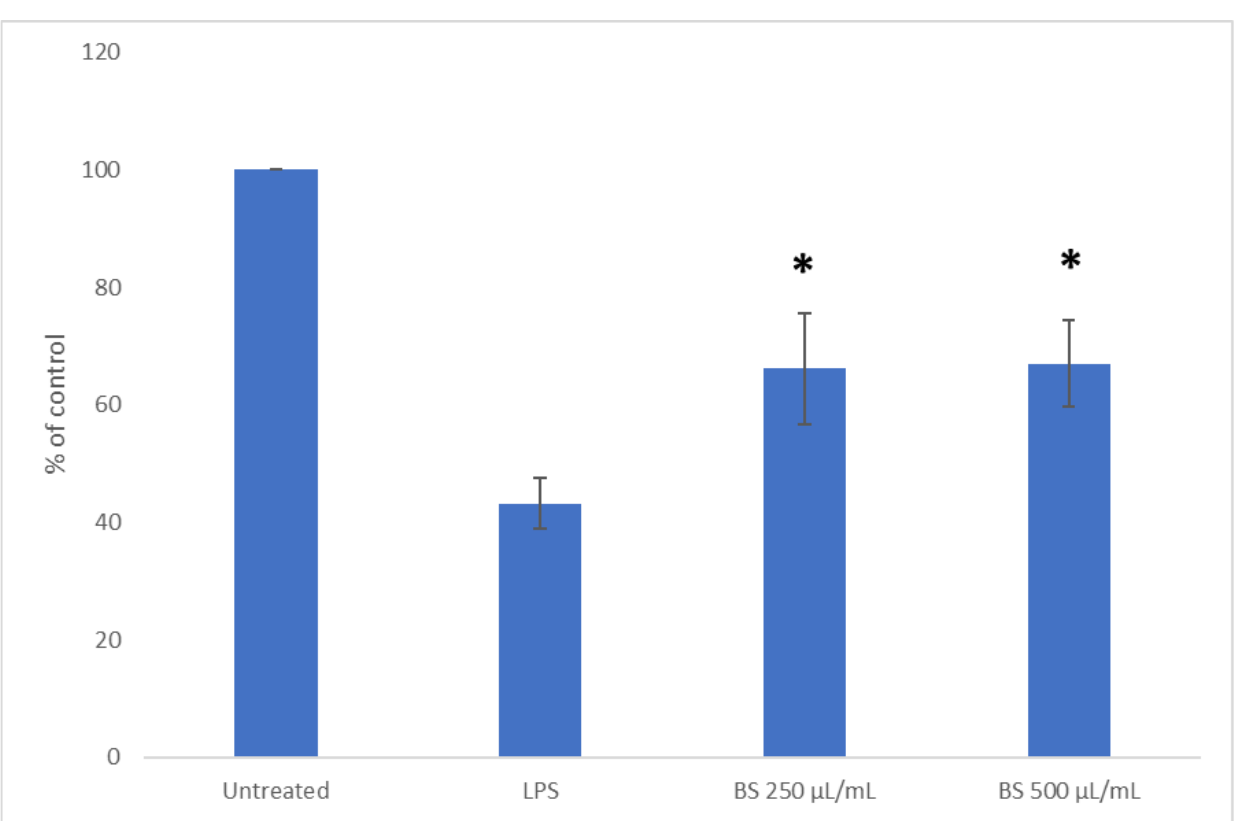
Figure 3. Effect of broccoli sprout extract (BS) on SOD1 activity in LPS-stimulated RAW 264.7 mac- Figure rophages. RAW cells were pre-treated with 250 and 500 µg/mL of sprout extract for 1 h; afterwards, cells were incubated with (10 ng/mL) or without LPS (untreated) for the next 24 h. Values are pre- sented as the mean ± SD (standard deviation) of three independent experiments in triplicate. Statis- tical analyses were carried out using one- way ANOVA and Tukey’s post -hoc test with *: p < 0.05 against the LPS-stimulated cells.